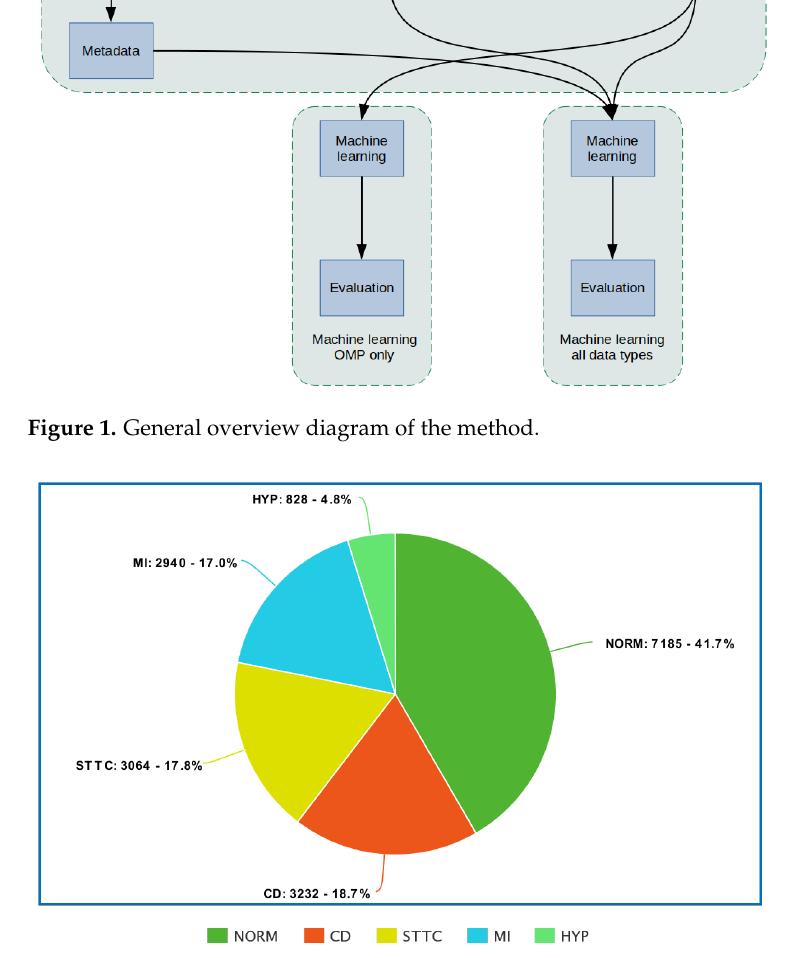
Figure 2. Distribution of PTB-XL database data by classes.